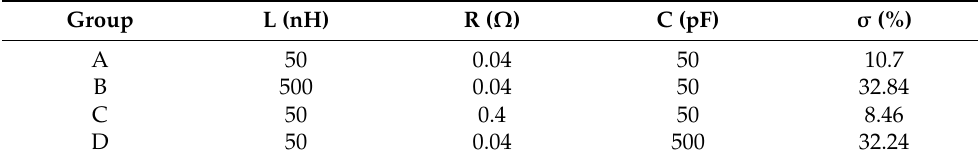
Table 4. Simulation on the simplified circuit